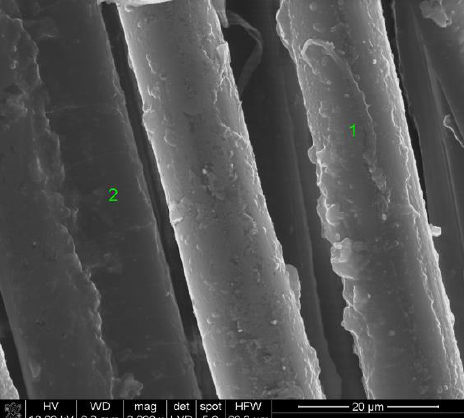
Figure 6. SEM image of (Ti,Si)N coated NATAN fabric, points “1” and “2” are marked for EDS analysis.